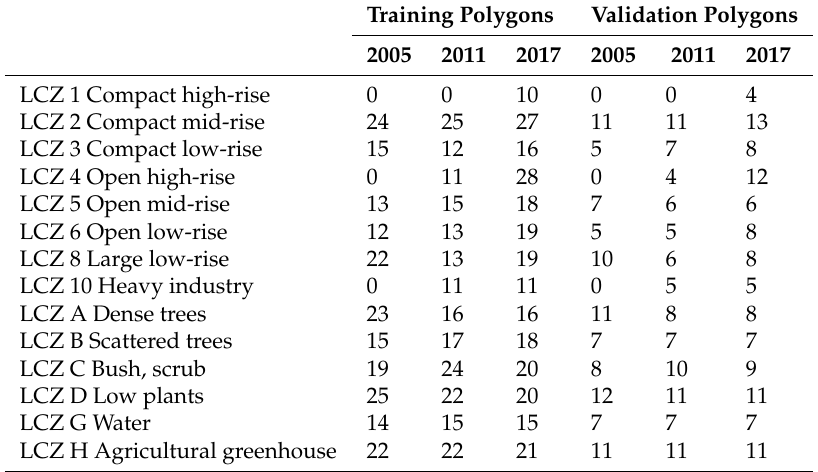
Table 2. Number of training and validation polygons of each zone, for 2005, 2011, and 2017. Training Polygons